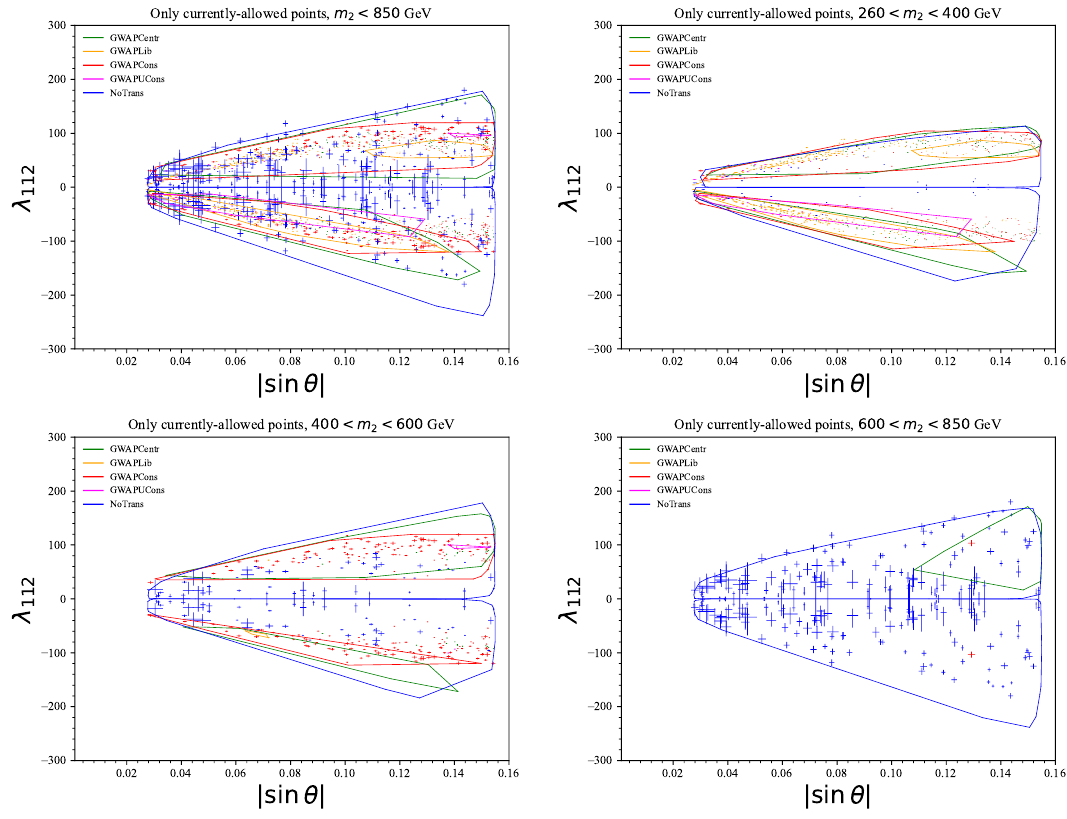
Figure 6 . The boundaries of the ( | sin θ | , λ 112 ) parameter space for m 2 < 850 GeV (top left), m 2 ∈ [260 , 400] GeV (top right), m 2 ∈ [400 , 600] GeV (bottom left) and m 2 ∈ [600 , 850] GeV (bottom right). The error bars show the expected 1 σ constraints obtained through the procedure outlined in the